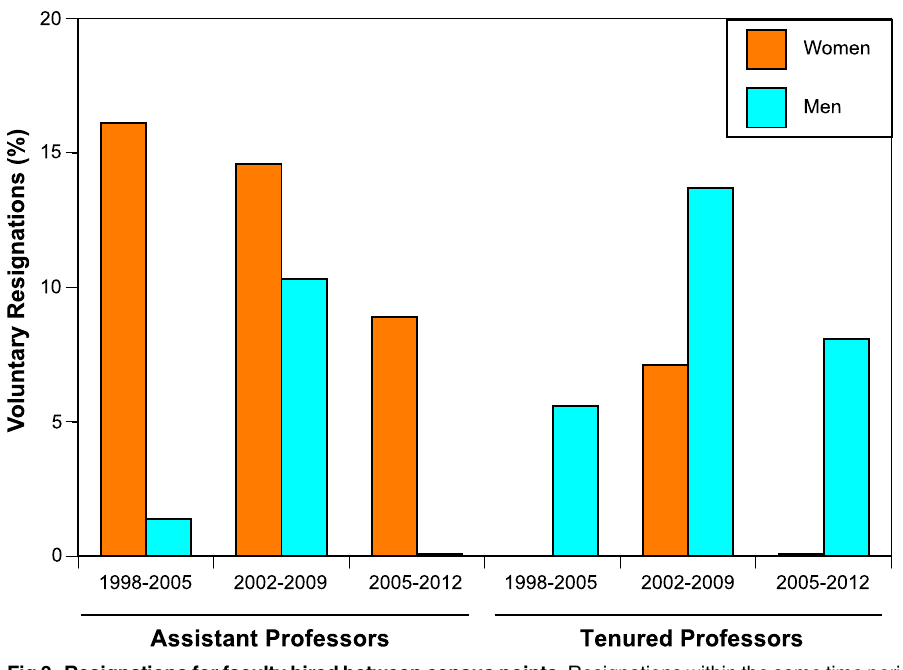
Fig 3. Resignations for faculty hired between census points. Resignations within the same time period (i.e. within 1 – 6 years of hire).